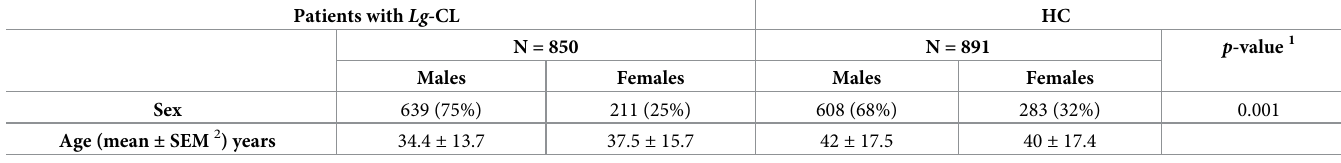
Table 1. Basic characteristics of the patients with Leishmania guyanensis -cutaneous leishmaniasis ( Lg -CL) and healthy controls (HC). Patients with Lg -CL